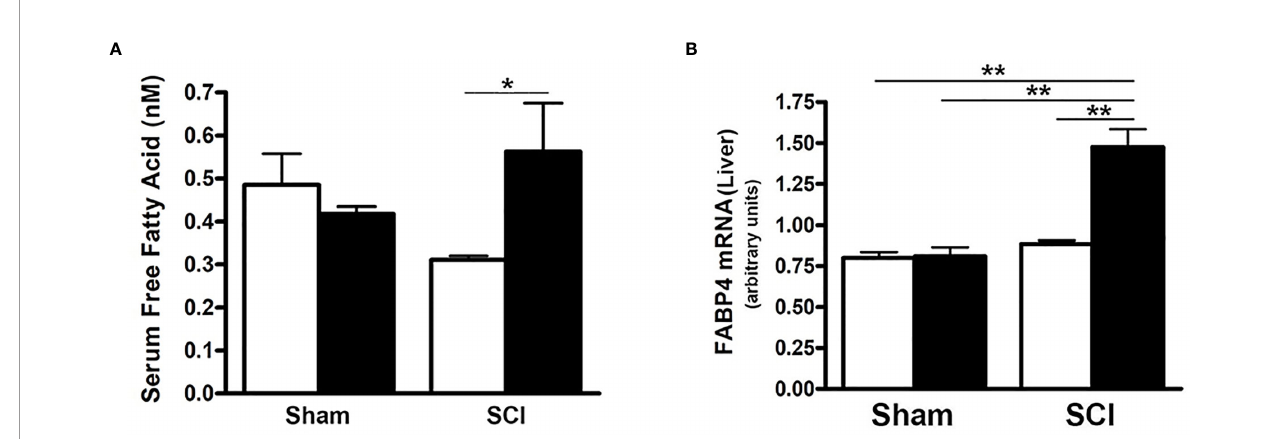
FIGURE 5 | Differential Effect of HFD on Serum FFA Level in Post-SCI and Sham Mice. Mice were fed with either ConD (White Bar) or HFD (Black Bar) after surgery. (A) , mouse serum was collected and subjected to ELISA for FFA serum level assay; (B) , total RNA was isolated and subjected to Rt-PCR for hepatic FABP4 mRNA expression. Data shown are means values ± SEM (n = 5). * p < 0.05; ** p <